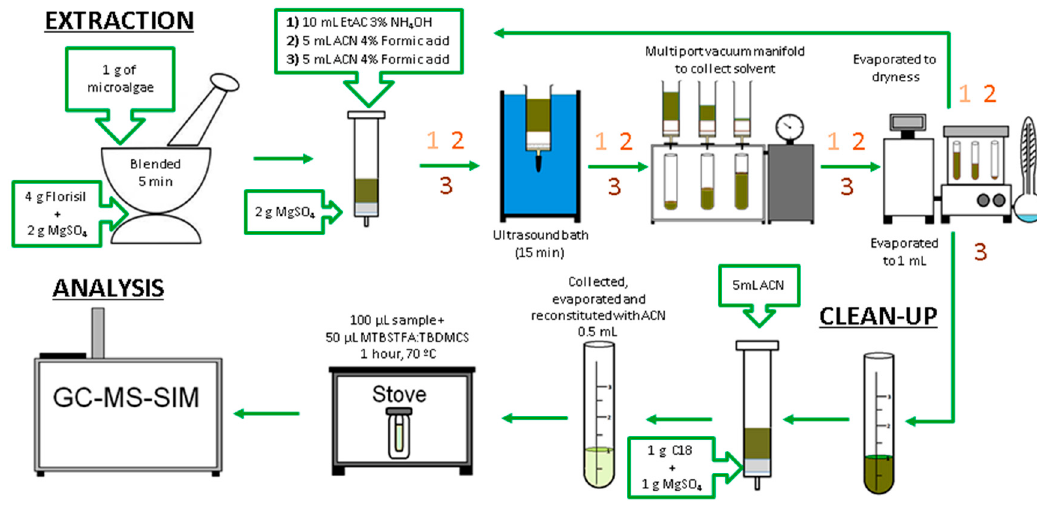
Figure 1. Workflow of the ultrasound assisted-matrix solid-phase dispersion (UA-MSPD) method used to extract contaminants of emerging concern from microalgae.